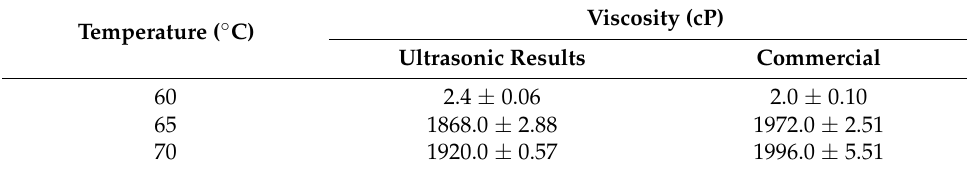
Table 3. Comparison of the viscosity of ultrasonic and commercial